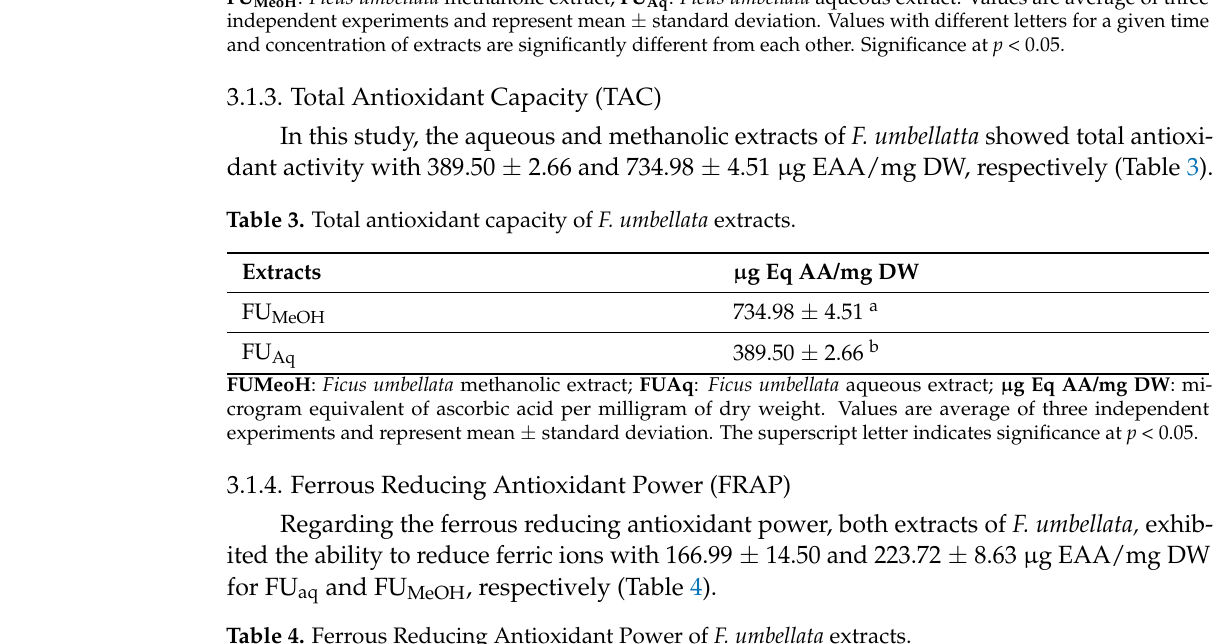
Table 4. Ferrous Reducing Antioxidant Power of F. umbellata extracts.